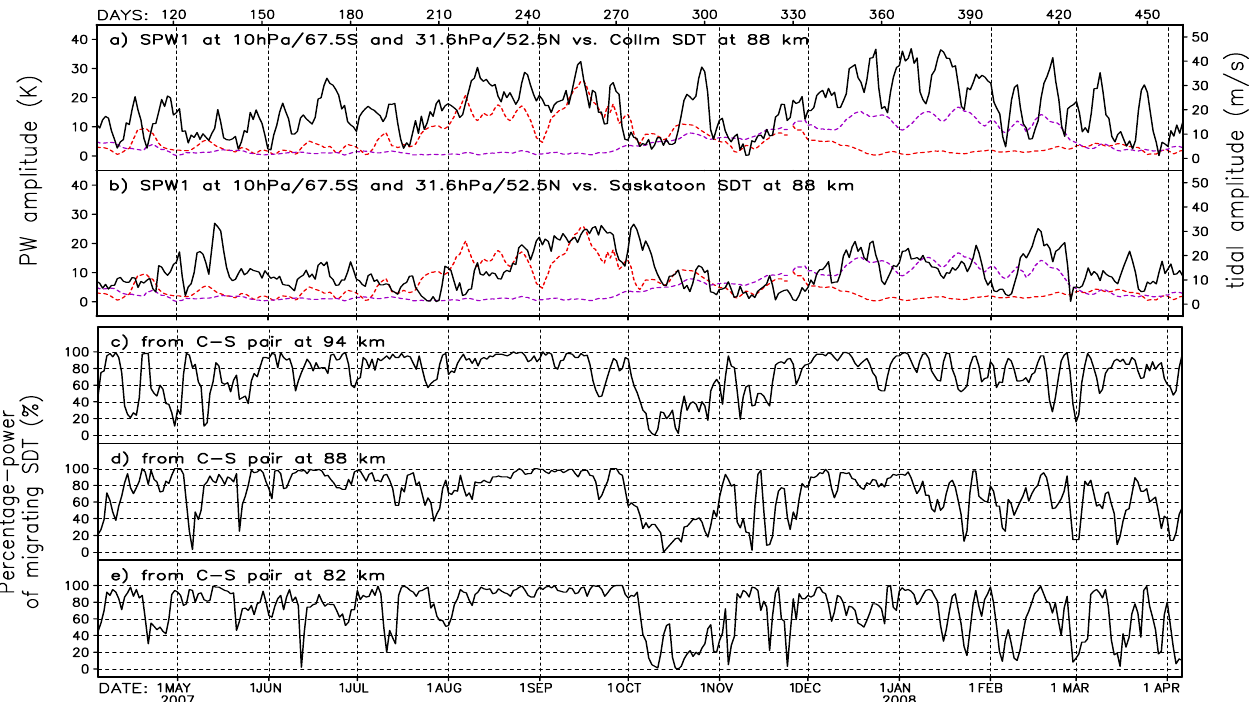
Fig. 6. Time sequences of the stationary planetary wave 1 amplitudes (dashed line; scale on left axis; shown in a and b) at 10hPa, 65–70 ◦ S (red) and at 32hPa, 50–55 ◦ N (purple) versus the amplitudes of 88km meridional semidiurnal tides (solid line; scale on right axis; showing in a and b) observed at Collm (a) and Saskatoon (b) during 2007/2008. The percentage-power in the migrating SDT derived from the Collm-Saskatoon pair is shown in the lower sections (solid lines, c–e